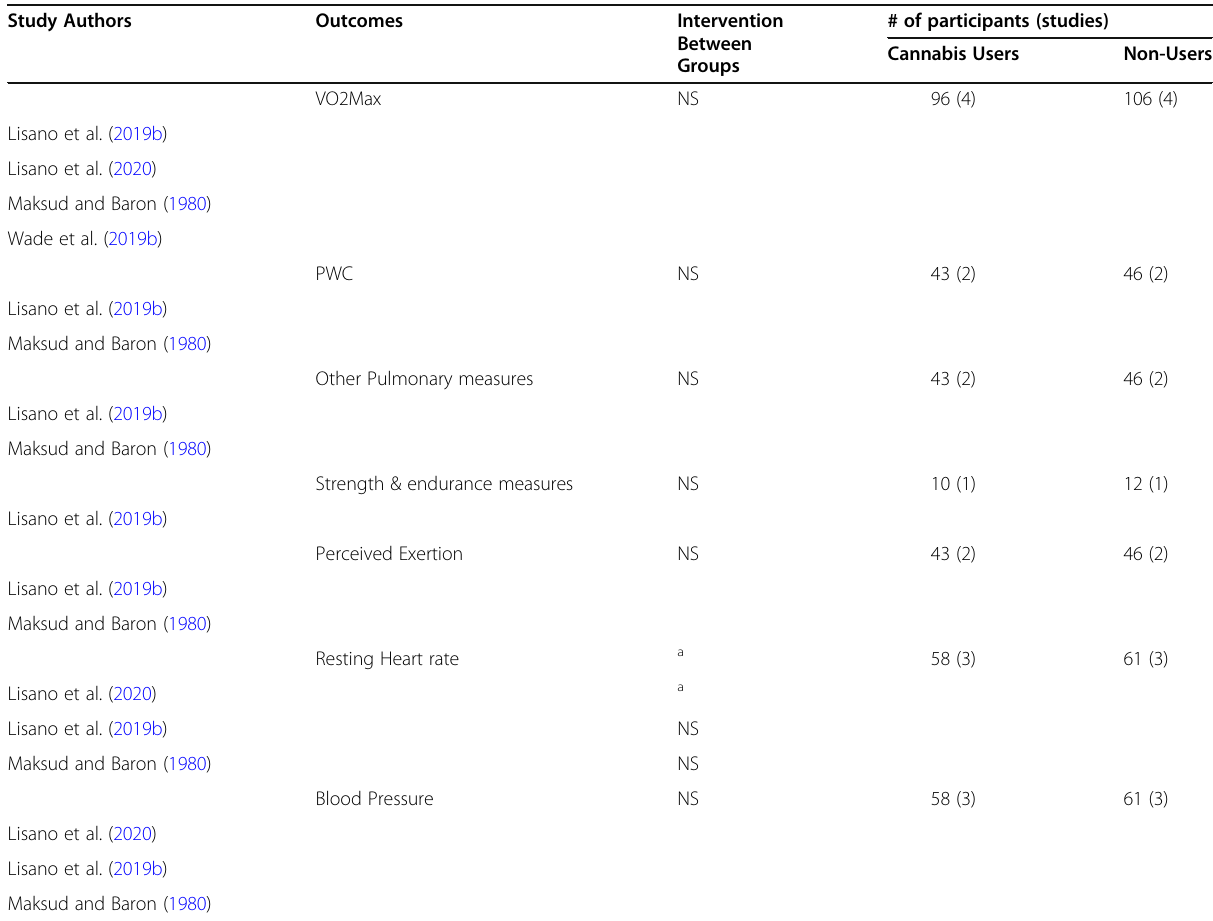
Table 3 Outcomes used in